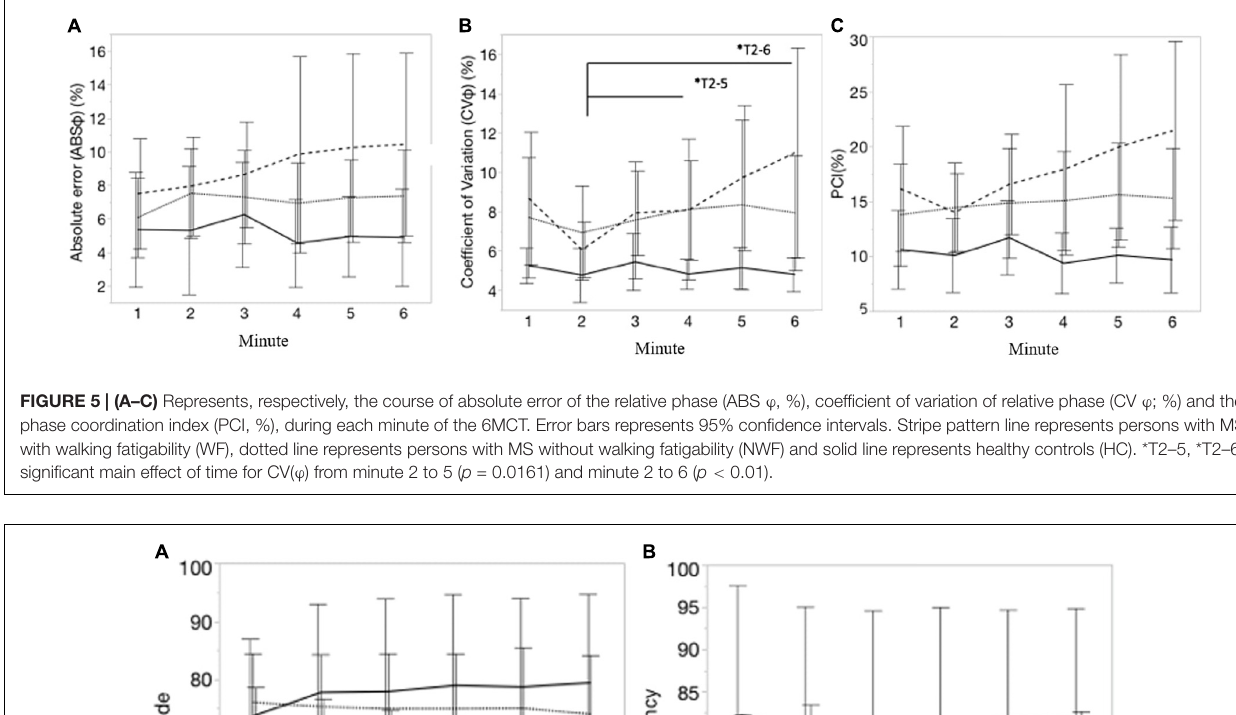
Frontiers in Human Neuroscience |